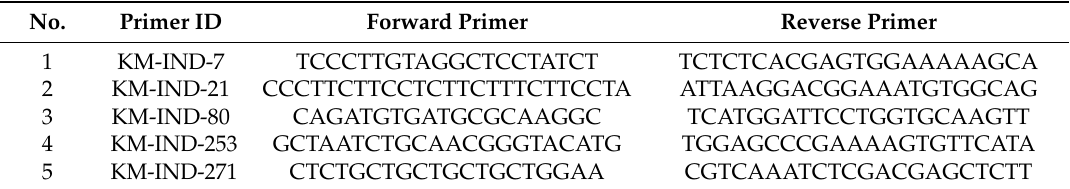
Table 3. Summary of validated InDel